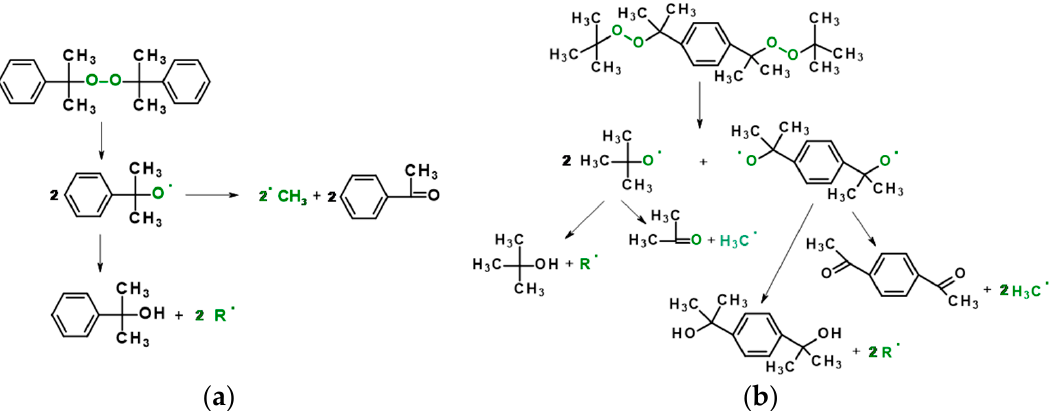
Scheme 1. Scheme of thermal decomposition mechanism of dicumyl peroxide (DCP) ( a ) and di-(2-